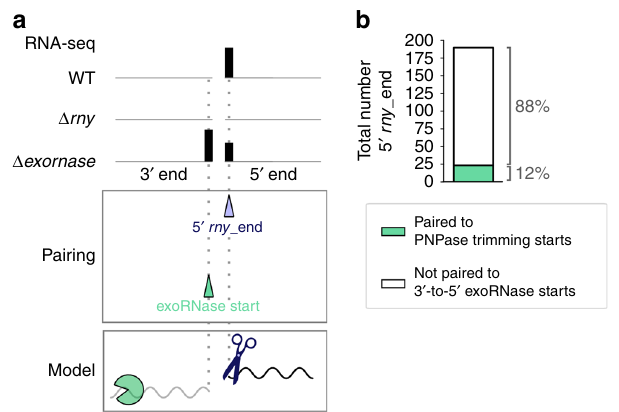
Fig. 5 PNPase completely degrades the RNase Y-generated RNAs located upstream of the processing site. a Example of 3 ′ and 5 ′ end coverage pro fi ling by RNA sequencing. The RNA ends that were more abundant in the WT strain than in the Δ rny strain (purple arrowhead) and the RNA ends corresponding to trimming start positions of exoRNases (green arrowhead) are indicated below the coverage. The 5 ′ rny _ends were paired to 3 ′ -to-5 ′ exoRNase start positions that were located at least 10 nt upstream (Supplementary Data 5). Subsequently to RNase Y activity, the 3 ′ -to-5 ′ exoRNases completely degraded the RNA fragments upstream of the RNase Y processing. b Portion of RNA 5 ′ ends (5 ′ rny _ends) paired with 3 ′ -to-5 ′ exoRNase start positions. All the trimming starts associated with 5 ′ rny _ends were PNPase trimming start 5 ′ ends generated by RNase Y (Fig. 4a, Supplementary Data 5). We